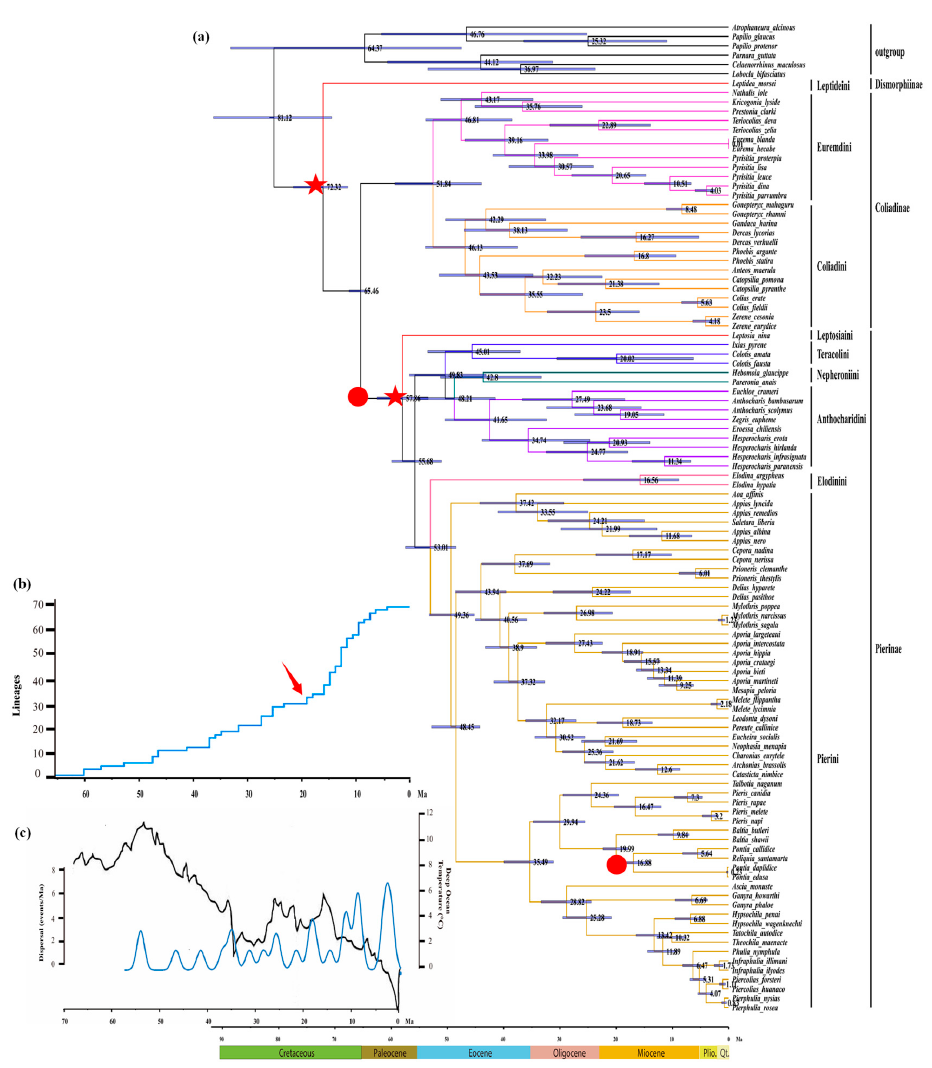
Figure 7. Estimated divergence dates and diversification rate of Pieridae and their association with geological and climatic events: ( a ) estimated time tree of the Pieridae; the blue bars represent